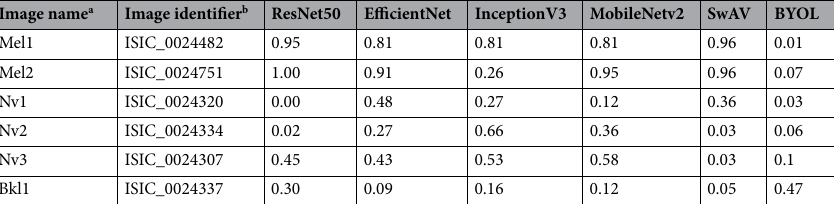
Table 1. Class prediction probabilities obtained for various images by the different CNN models available in DUNEScan . The predictions are represented as probability of malignancy, p (malignancy). The probability of benignancy can be obtained by 1- p (malignancy). a Arbitrary name used as a reference in this publication. b ISIC image